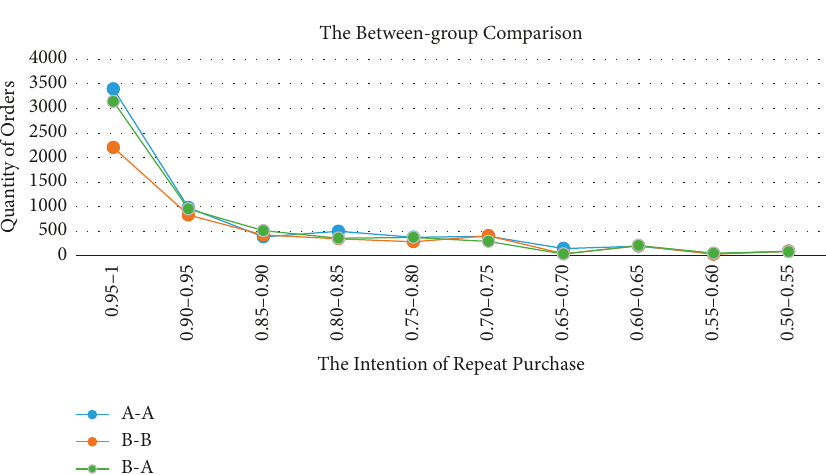
Figure 6: Comparison of A-A and A-B groups.